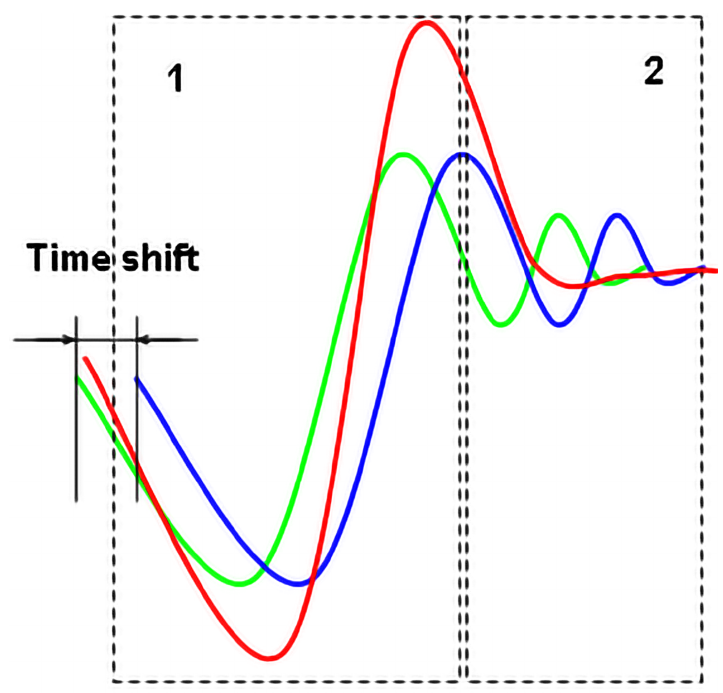
Figure 1. Generating the composite seismic signal with enhanced